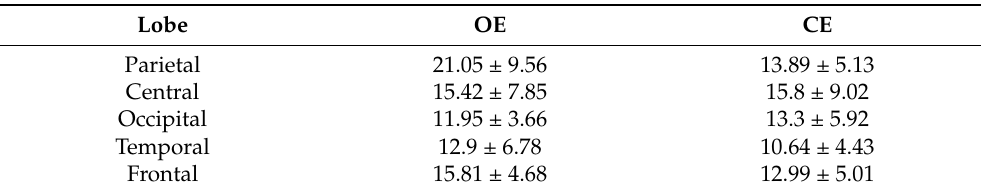
Table 4. Average results, by cerebral lobes, of the beta band absolute power (µV2/Hz) obtained in the control tests opened eyes (OE) and closed eyes (CE).